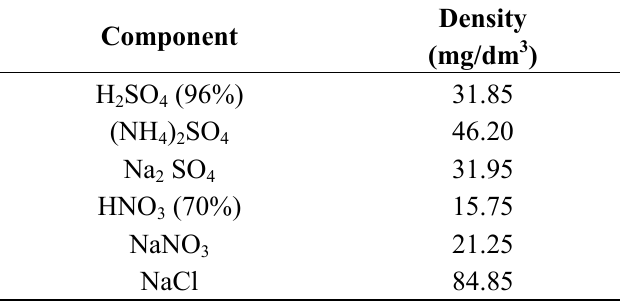
Table 5. Synthetic acid rain (pH = 3.4)